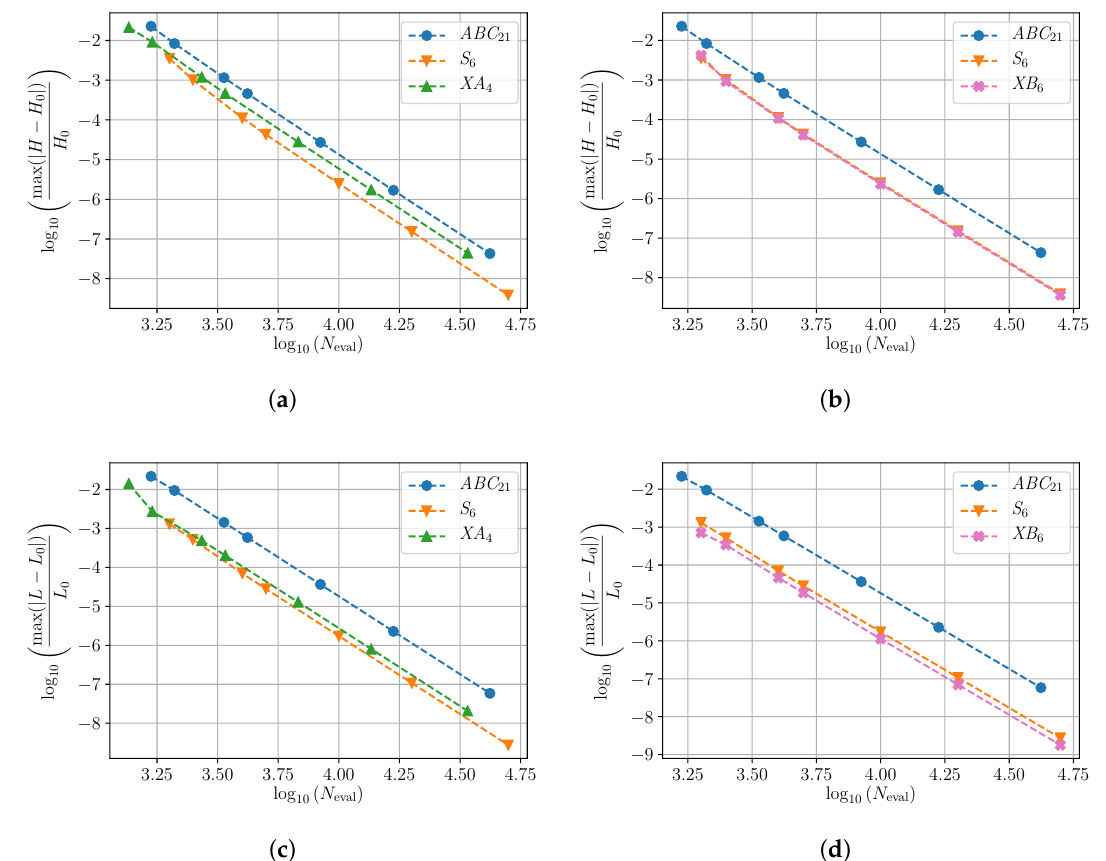
Figure 1. Relative error in conserved quantities due to each of the best numerical methods tested for charged particle under Lorentz force. ( a ) Relative error in energy for XA 4 compared to ABC 21 and S 6 . ( b ) Relative error in energy for XB 6 compared to ABC 21 and S 6 . ( c )Relative error in angular momentum for XA 4 compared to ABC 21 and S 6 . ( d ) Relative error in angular momentum for XB 6 compared to ABC 21 and S 6